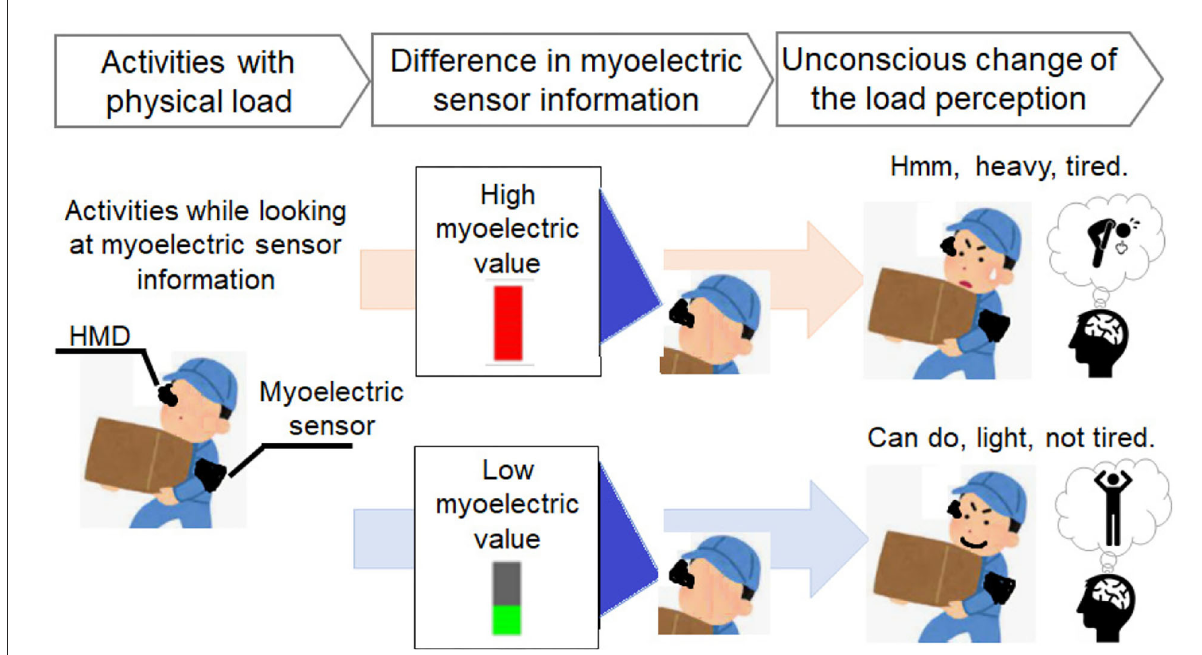
FIGURE1 Hypothesis. The phenomenon of change in load due to browsing of muscle activity (Futami et al., 2021a).